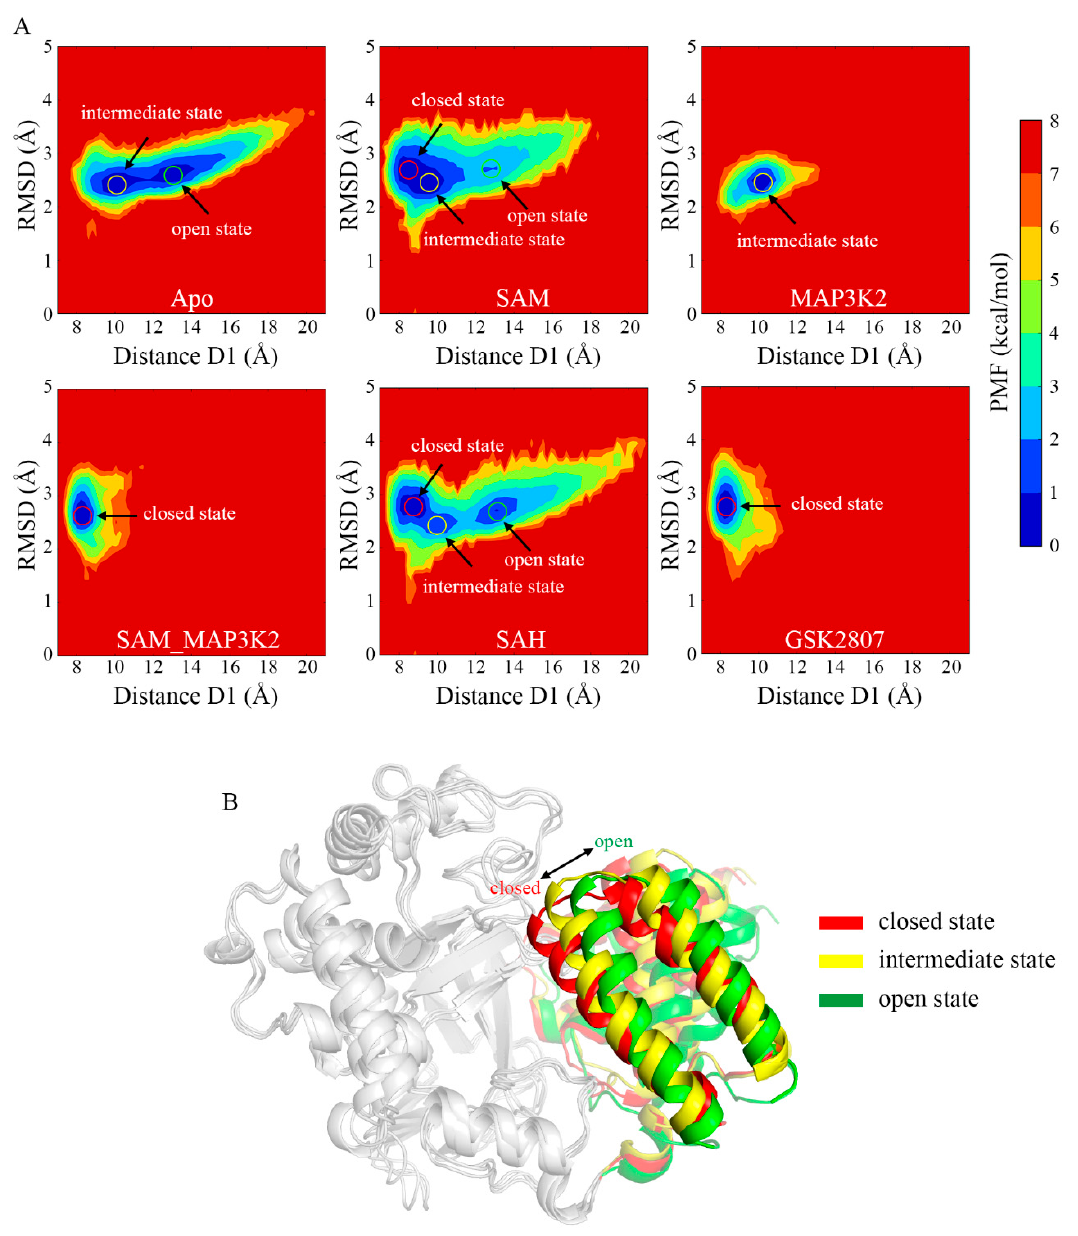
Figure 3. Conformational states of SMYD3 during MD simulations. ( A ) PMF calculated for the distance D1 vs. the RMSD of SMYD3. ( B ) Representative structures of the closed (red), intermediate (yellow), and open (green) states. Only the CTD is colored for comparison purposes.